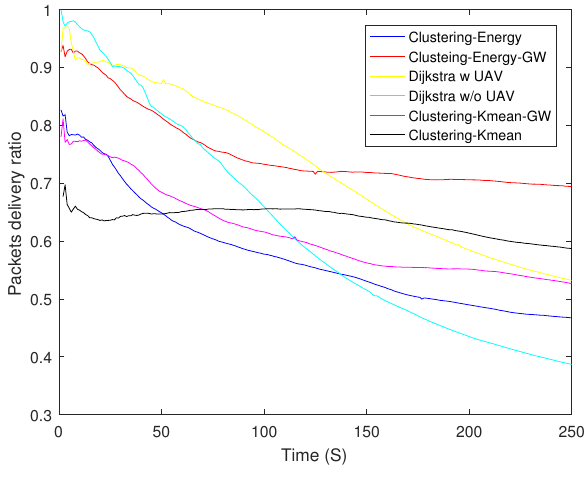
Figure 10. Packet delivery